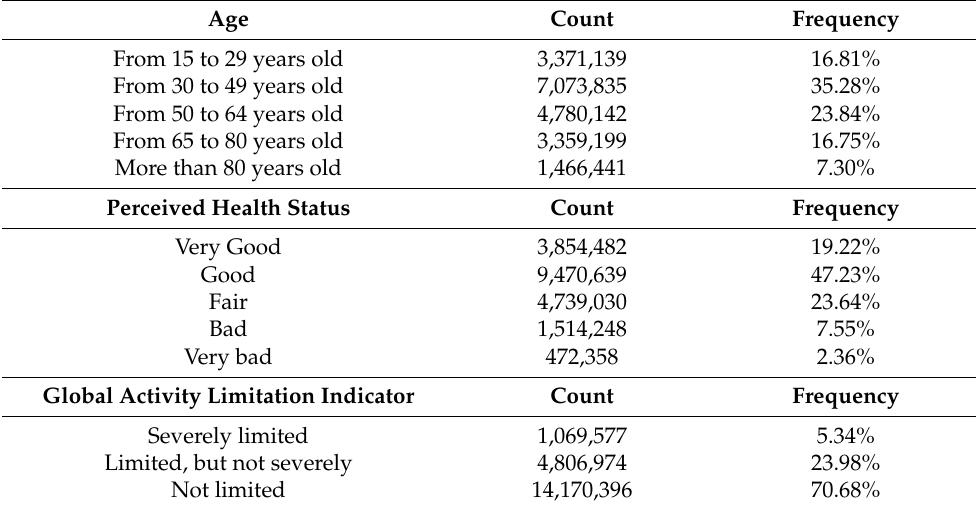
Table 1. Sociodemographic